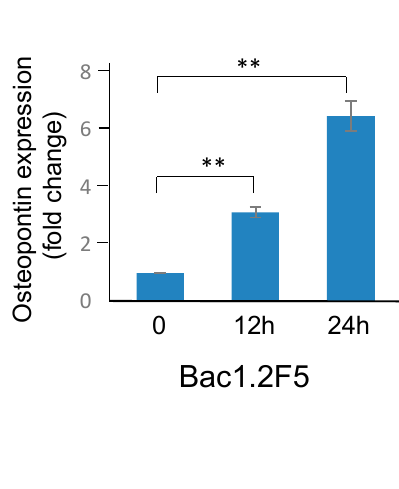
Figure 5. CSF-1 increases spp1/osteopontin mRNA expression in murine macrophages, prostate cancer cells and breast cancer cells. ( A ) Representative image (n = 3) of Bac1.2F5 murine macro- phages cultured in the presence of CSF-1. ( B ) Relative expression of spp1/osteopontin mRNA was assessed by qRT-PCR performed in triplicate (normalized against RPLP38). Starved Bac1.2F5 cells